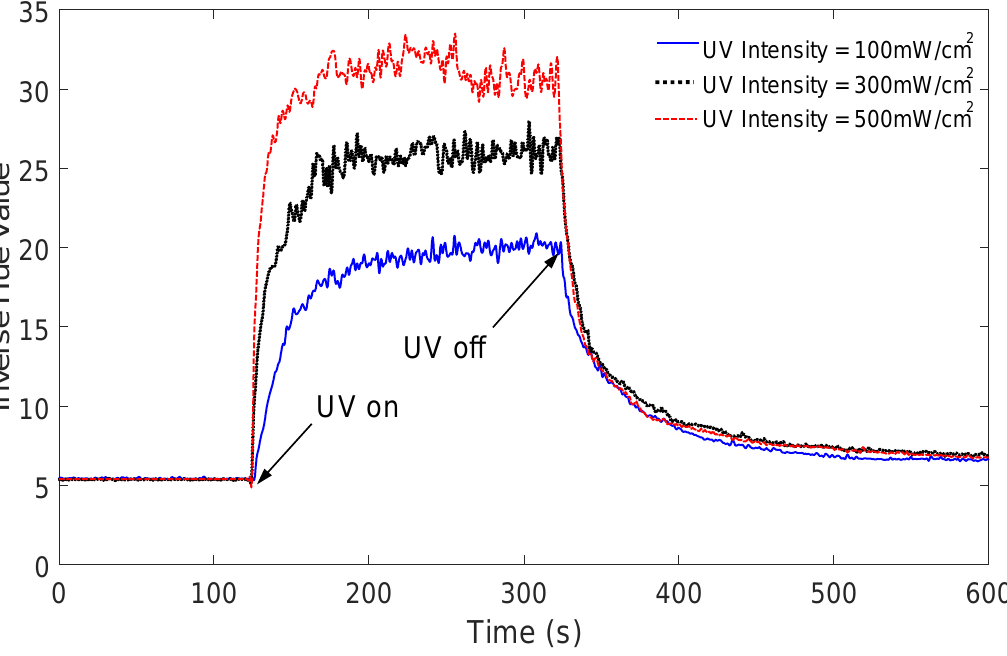
Figure 9. Transient response of inverse hue value at different UV light intensities.